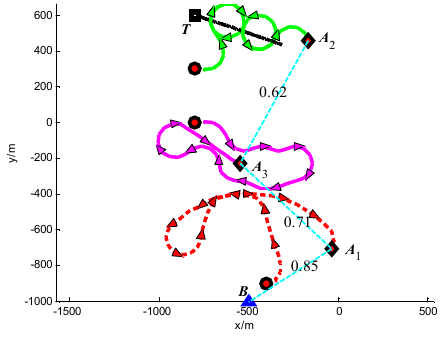
Figure 28. Trajectories of UAVs and target at t = 50 s (Group A in Scenario 3).